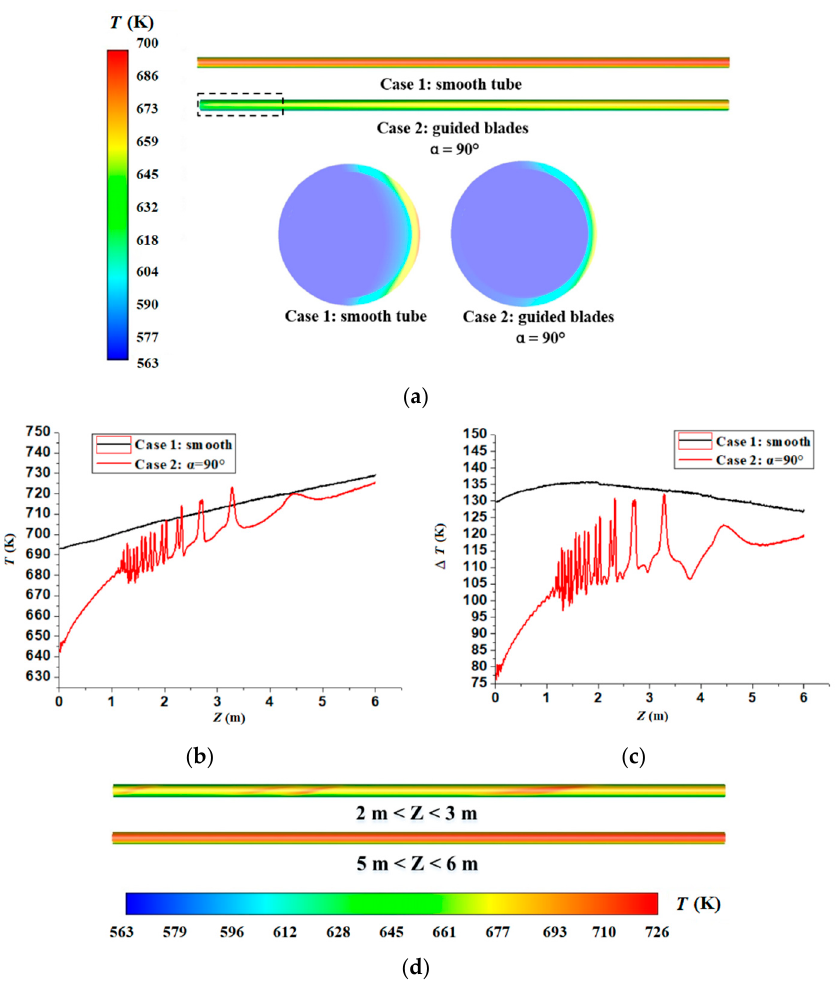
Figure 8. Temperature distributions of the smooth tube and the tube with guide vanes: ( a ) temperature contours on S1 and S2; ( b ) temperature distributions on Line 1; ( c ) temperature differences along the tube; ( d ) temperature contours in downstream region of Case 2.